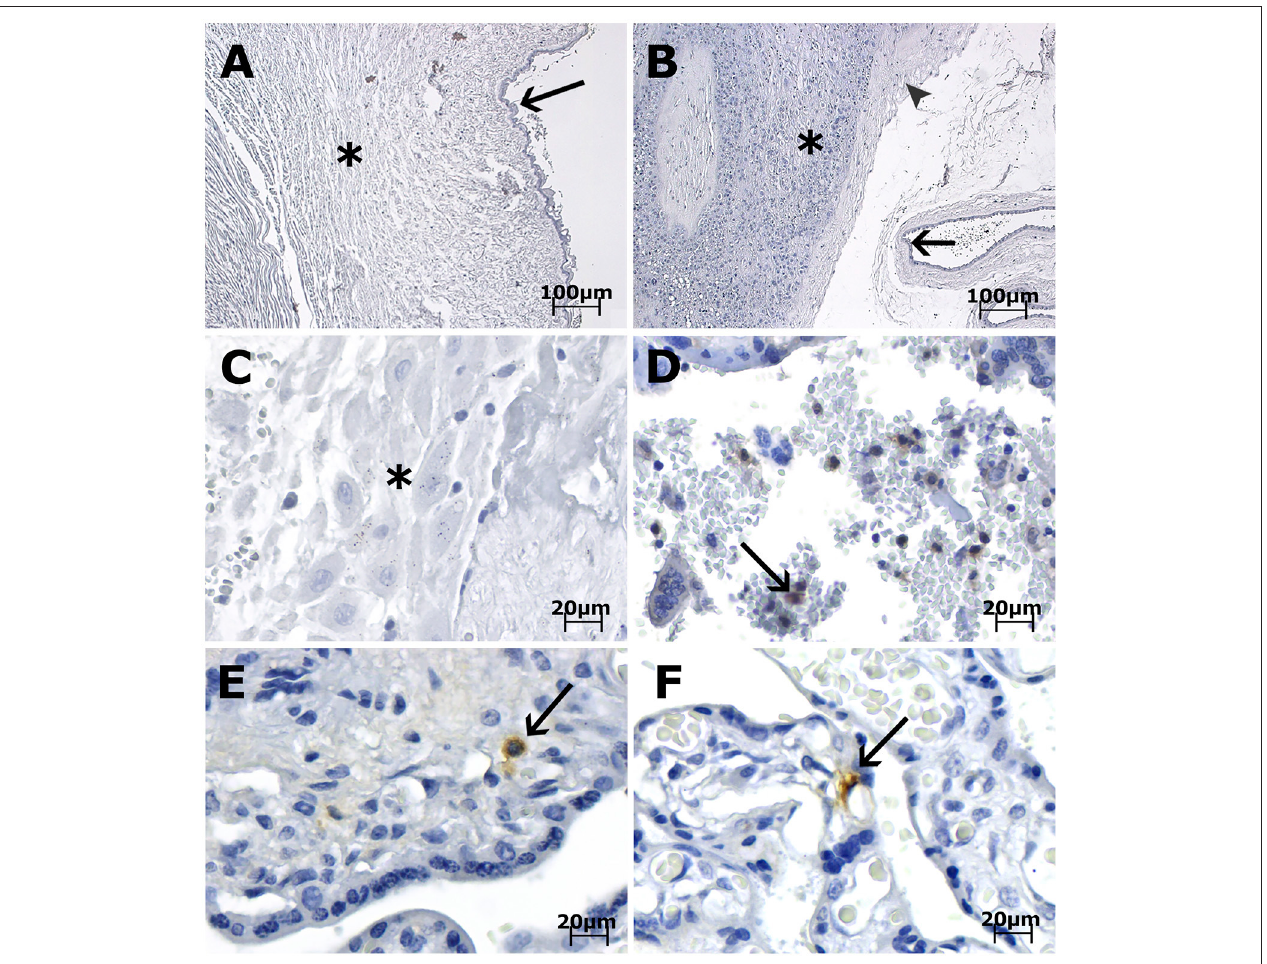
FIGURE 3 | Photomicrography of placenta, cord and membrane samples from women diagnosed as positive for ZIKV infection immunostained with anti-ZIKV MAb and stained with Harris’s hematoxylin. The scale bars are 100 µ m (A,B) and 20 µ m (C–F) . (A) Case LRV/16 515—Umbilical cord slides from a third trimester placenta negative for anti-ZIKV MAb. Fibroblasts in Wharton’s jelly (*) and amniotic epithelium (arrow) are negative for the antibody used. (B) Case LRV/16 515—Chorioamniotic membrane from a third trimester placenta negative for anti-ZIKV MAb. Notice that the capsular decidua (*), the smooth chorion above the capsular decidua (arrowhead) and the amniotic epithelium (arrow) are negative for the antibody used. (C) Case LRV/16 515—Decidua basalis (*) from a third trimester placenta negative for anti-ZIKV MAb. (D) Case LRV/15 572—Intervillous space from a first trimester placenta with inflammatory cell infiltrates positive for anti-ZIKV MAb (arrow). (E) Case LRV/16 927 and (F) Case LRV/16 848: Chorion frondosum from third trimester placentas showing Hofbauer cells positive for anti-ZIKV MAb (arrows) inside the chorionic villi. Notice that the cytotrophoblast and syncytiotrophoblast cells, as well as fibroblastic cells inside Wharton’s jelly, are negative for the antibody